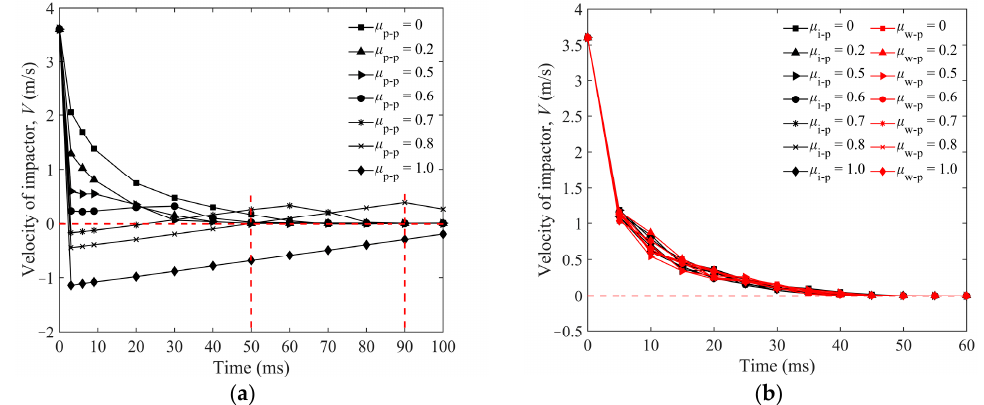
Figure 15. Time evolution of vertical velocity of impactor with sphere impacting into the granular bed of L p = 6 mm elongated particles: ( a ) condition Ⅰ and ( b ) condition Ⅱ and Ⅲ . Condition Ⅰ : μ i-p = 0.2, μ w-p = 0.34 and various μ p-p s; condition Ⅱ : μ p-p = 0.2, μ w-p = 0.34 and various μ i-p s; condition Ⅲ : μ p-p = 0.2, μ i-p = 0.2 and various μ w-p s. (The dotted lines are used to clearly mark the velocity of the impactor at different times).